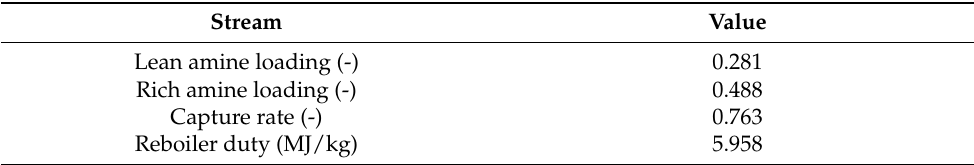
Table 2. Base case